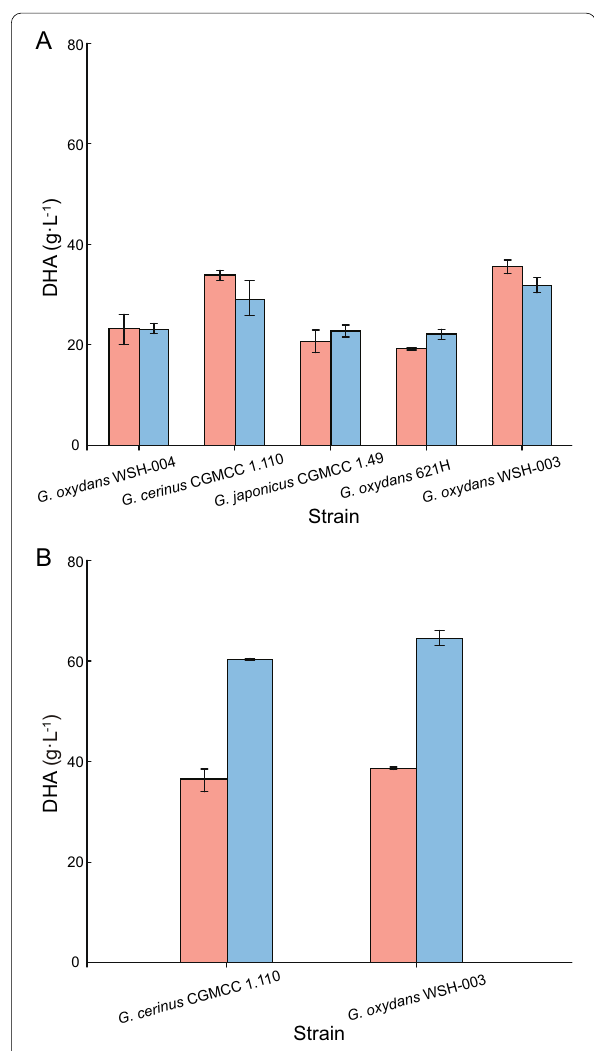
Fig. 1 DHA production levels in five wild-type strains. Fermentation was conducted in 500 mL shaking flasks for 72 h. A DHA production in five industrial wild-type strains ( G. oxydans WSH-004, G. cerinus CGMCC 1.110, G. japonicus CGMCC 1.49, G. oxydans 621H, and G. oxydans WSH-003) in culture medium containing different glycerol concentrations. B DHA production in two wild-type strains in improved culture medium with different glycerol concentrations. Pink; 50 g L − 1 initial glycerol; Blue; 100 g L − 1 initial